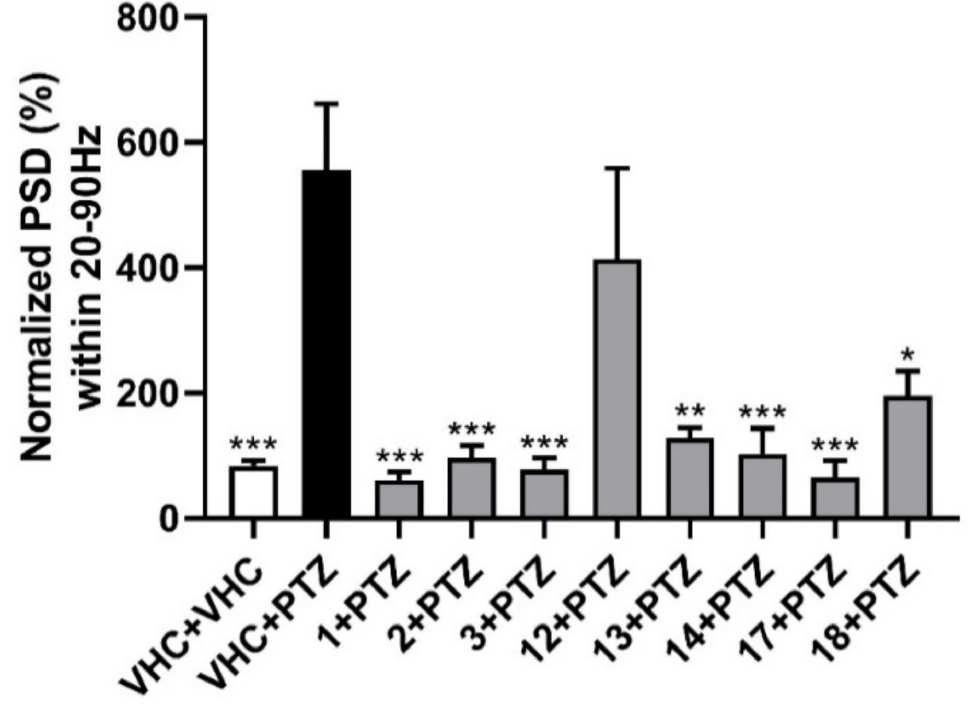
Figure 3. Electrophysiological antiseizure analysis of coumarins used in this study. Non-invasive local field potential recordings from the optic tectum of larvae pre-exposed to vehicle (VHC) only, VHC and pentylenetetrazole (PTZ), or test compound and PTZ. Normalized power spectral density (PSD) in defined frequency band of 20–90 Hz per individual larva is shown (mean ± SEM). Number of replicates: n = 9–10 for each compound group and n = 29–30 for the VHC + VHC and VHC + PTZ controls. Statistical analysis: one-way ANOVA with Dunnett’s multiple comparisons test (GraphPad Prism 7). Significance levels: * p < 0.05; ** p < 0.01; *** p <